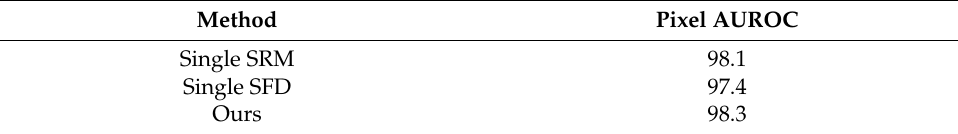
Table 3. Influence of a single module on the SFC.